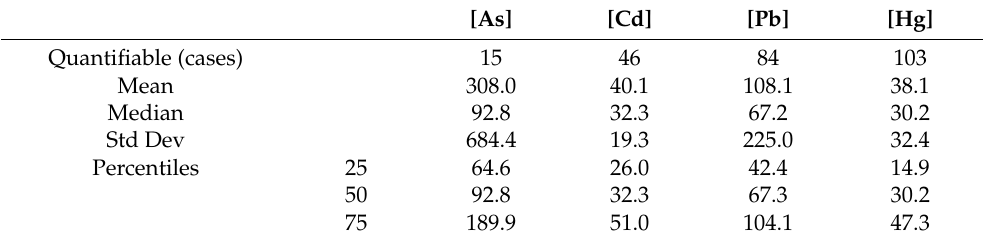
Table 6. Main significant correlations. Significant Spearman’s Rho values ( p < 0.05). [As] [Cd] [Hg] [Pb] 0.91 Maternal age 0.35 − 0.63 White fish intake